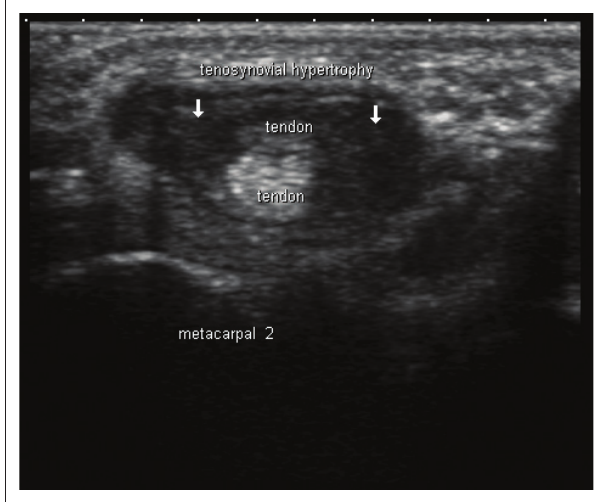
FIGURE 2: Transverse ultrasound image at the level of the second metacarpal demonstrating tenosynovitis of the extensor tendons of the hand.